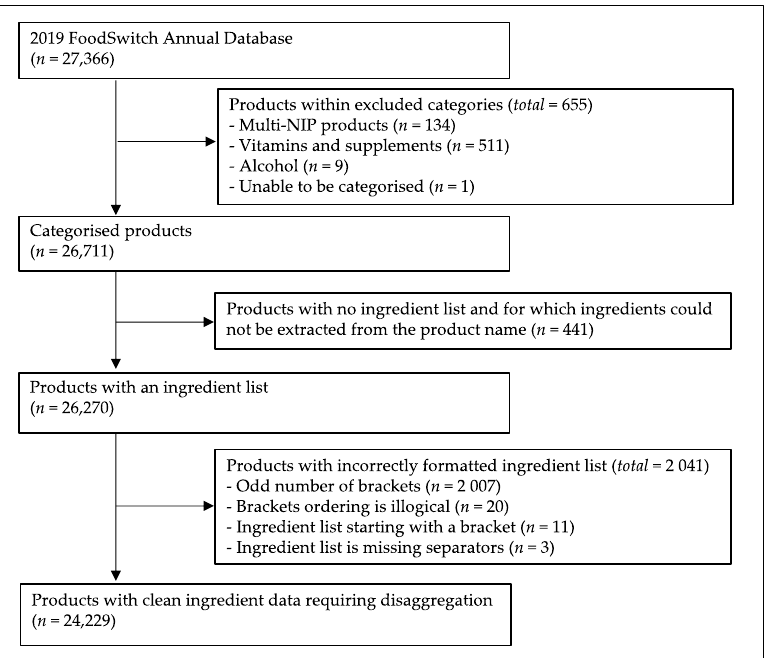
Figure A2. Flowchart describing product inclusion. The 2019 FoodSwitch Annual Database extract is comprised of products scanned during the in-store surveys done between August and November 2019 in Sydney locations of the following large supermarkets: IGA, ALDI, Woolworths, Coles and Figure A3 Harris Farm.